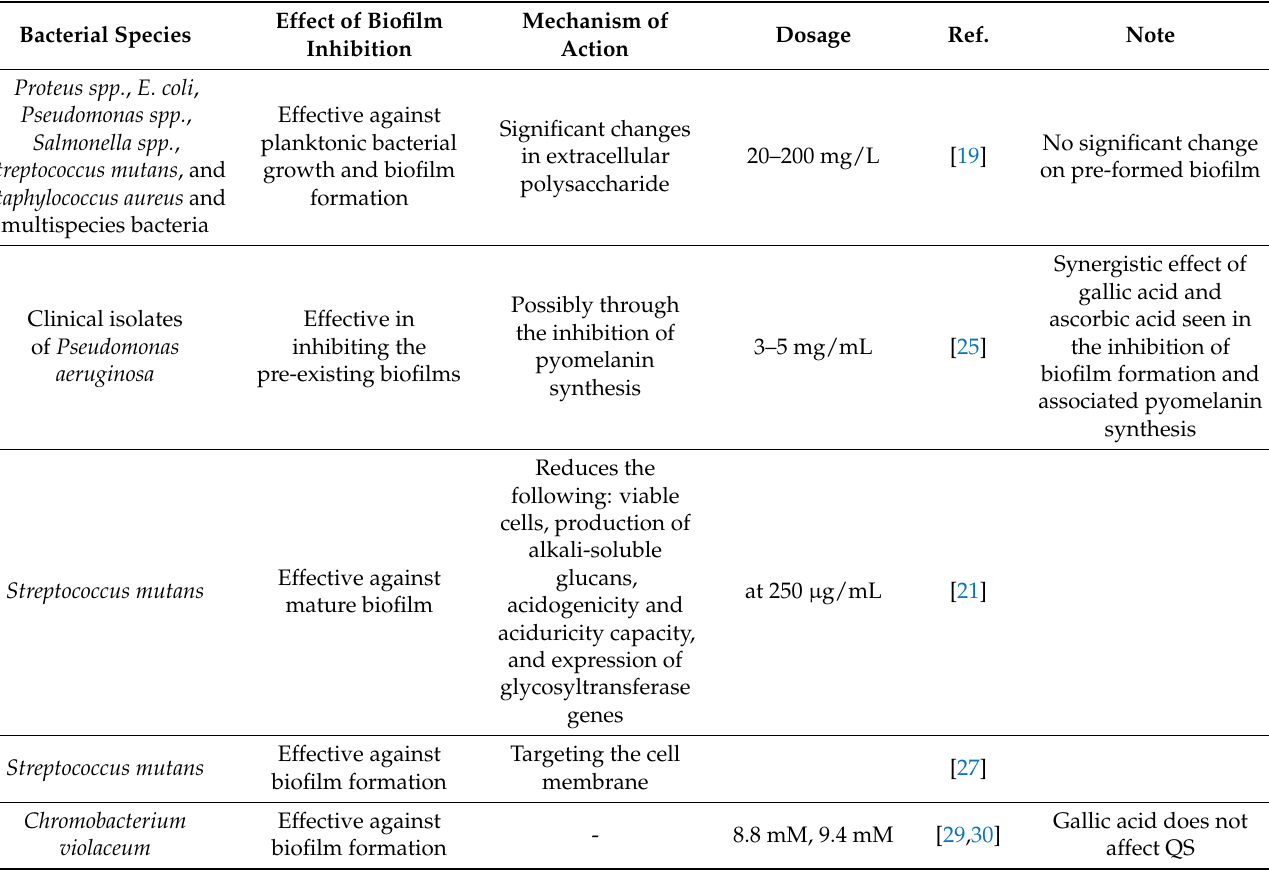
Table 1. Gallic acid inhibition of biofilm formation by several bacterial species and its suggested mechanisms of